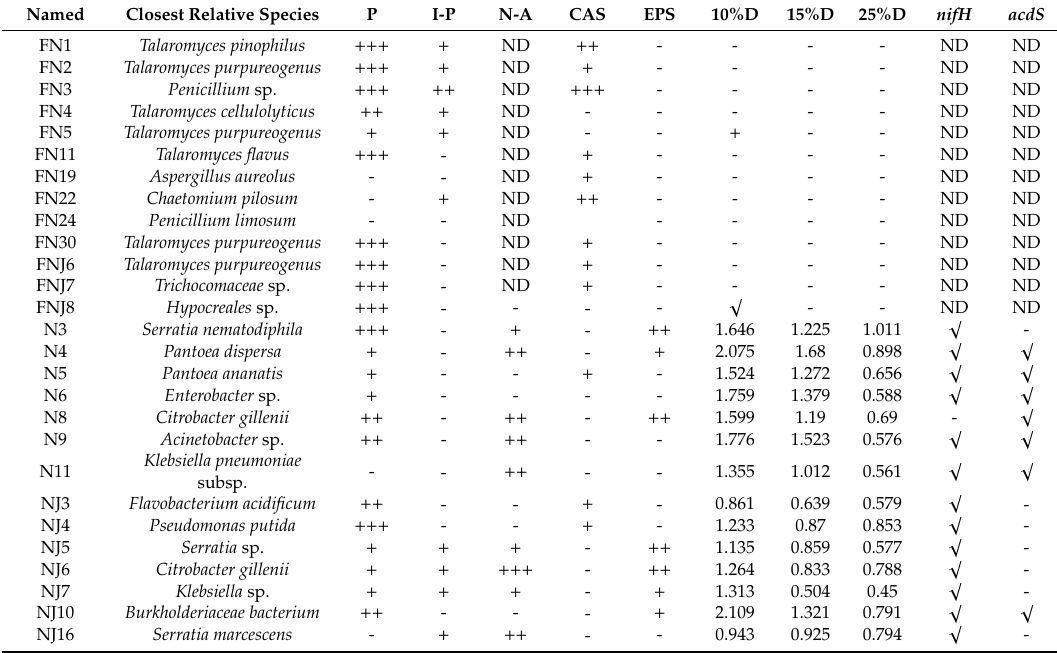
Table 1. Identification, plant growth promoting traits and drought stress tolerance of the endophytic and rhizosphere isolates selected for in vitro plant growth-promoting (PGP) traits. Named Closest Relative Species P I-P N-A CAS FN1